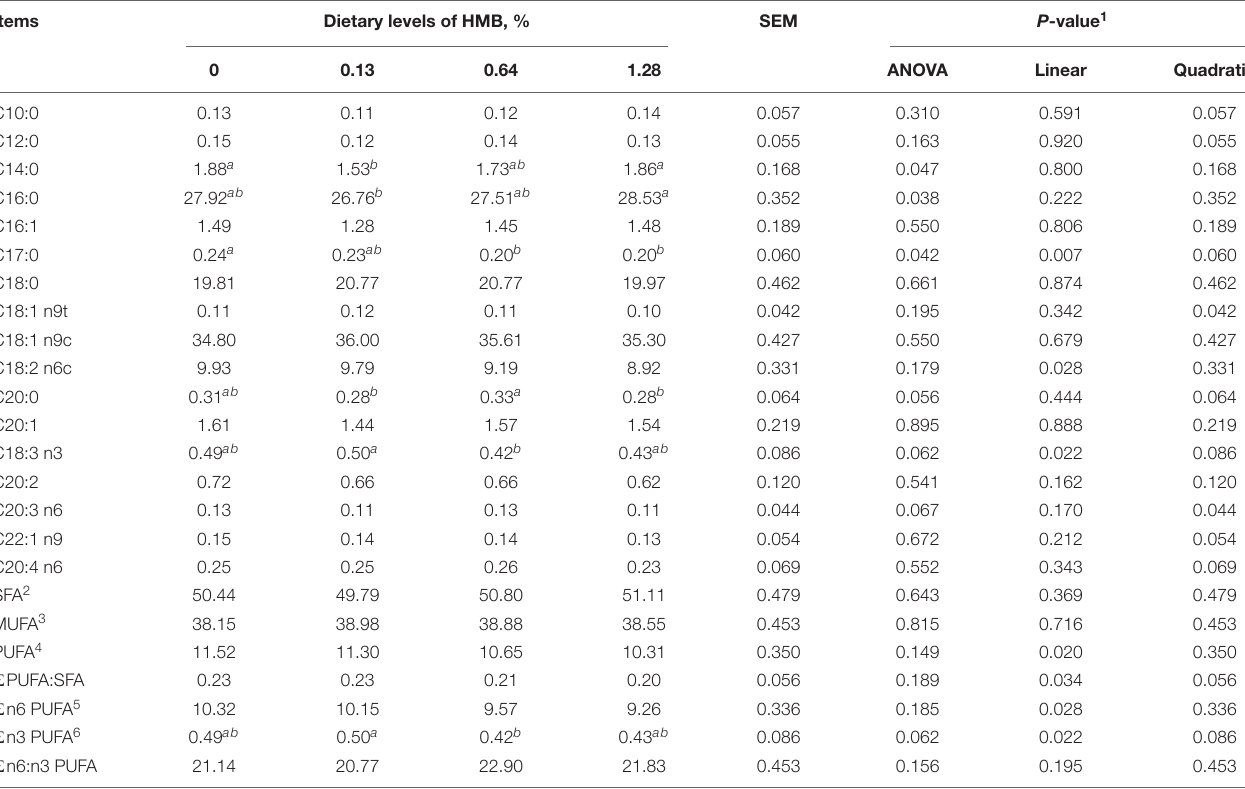
TABLE 2 | Fatty acid composition of abdominal subcutaneous adipose tissue in Bama Xiang mini-pigs fed the diets with various levels of HMB (% of total fatty